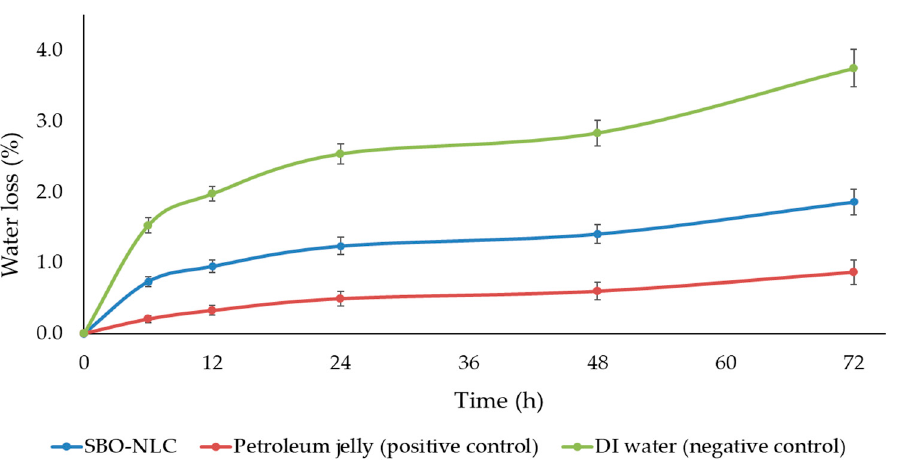
Figure 7. Graphical representation of occlusion effect (percentage water loss) of the SBO-NLCs. Petroleum jelly served as the positive control.